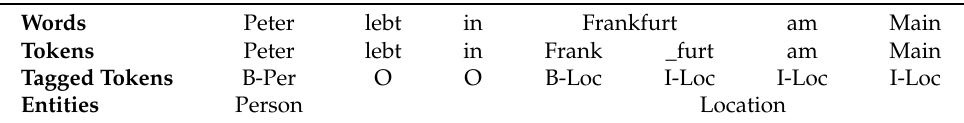
Table 3. IOB tagging example with unlabeled words (O) and the two entities: “location” (Loc) and “person” (Per). The first tag of each entity is prefixed with “B-”, while all the following tokens of that entity are marked with an “I-”. The first row are the words of the sentence that are split into one or more tokens (second row). The third row shows the tagged tokens based on the given entities (last row). The example sentence can be translated as “Peter lives in Frankfurt am